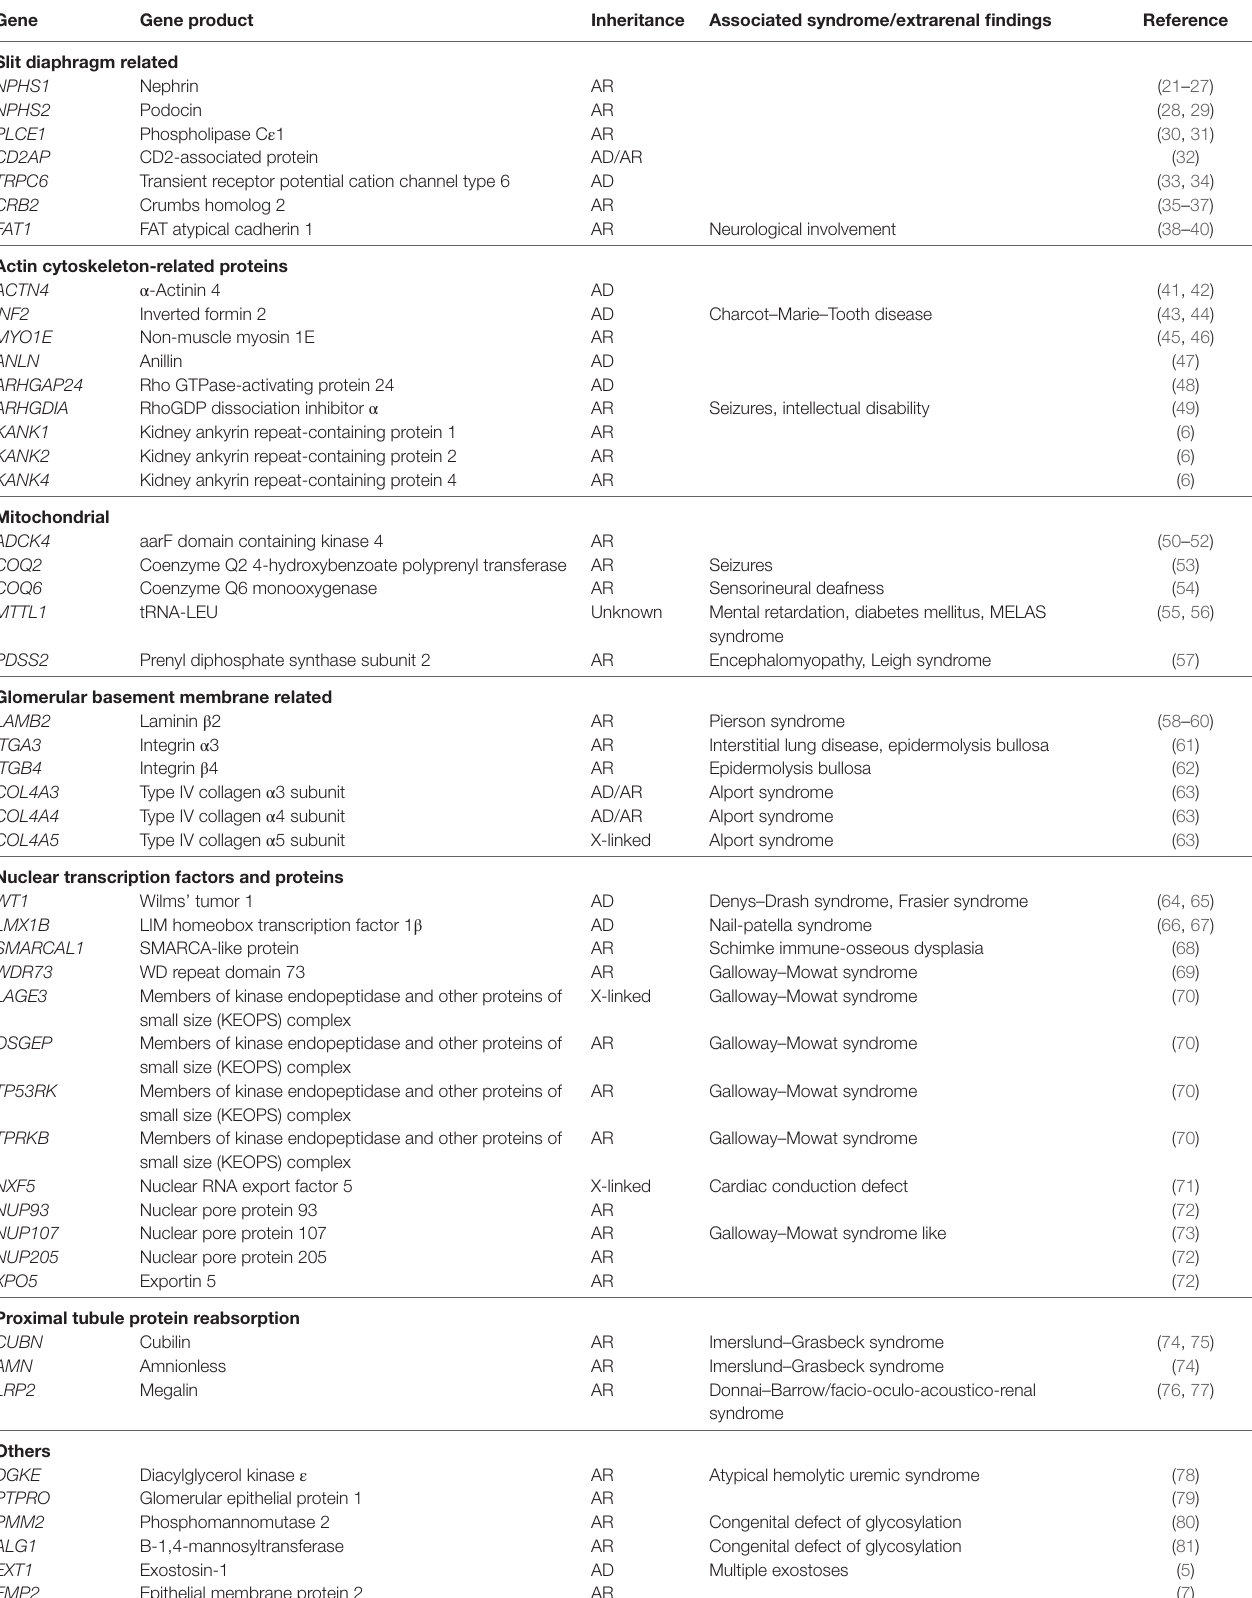
TAbLe 1 | Monogenic forms of nephrotic syndrome and proteinuria.